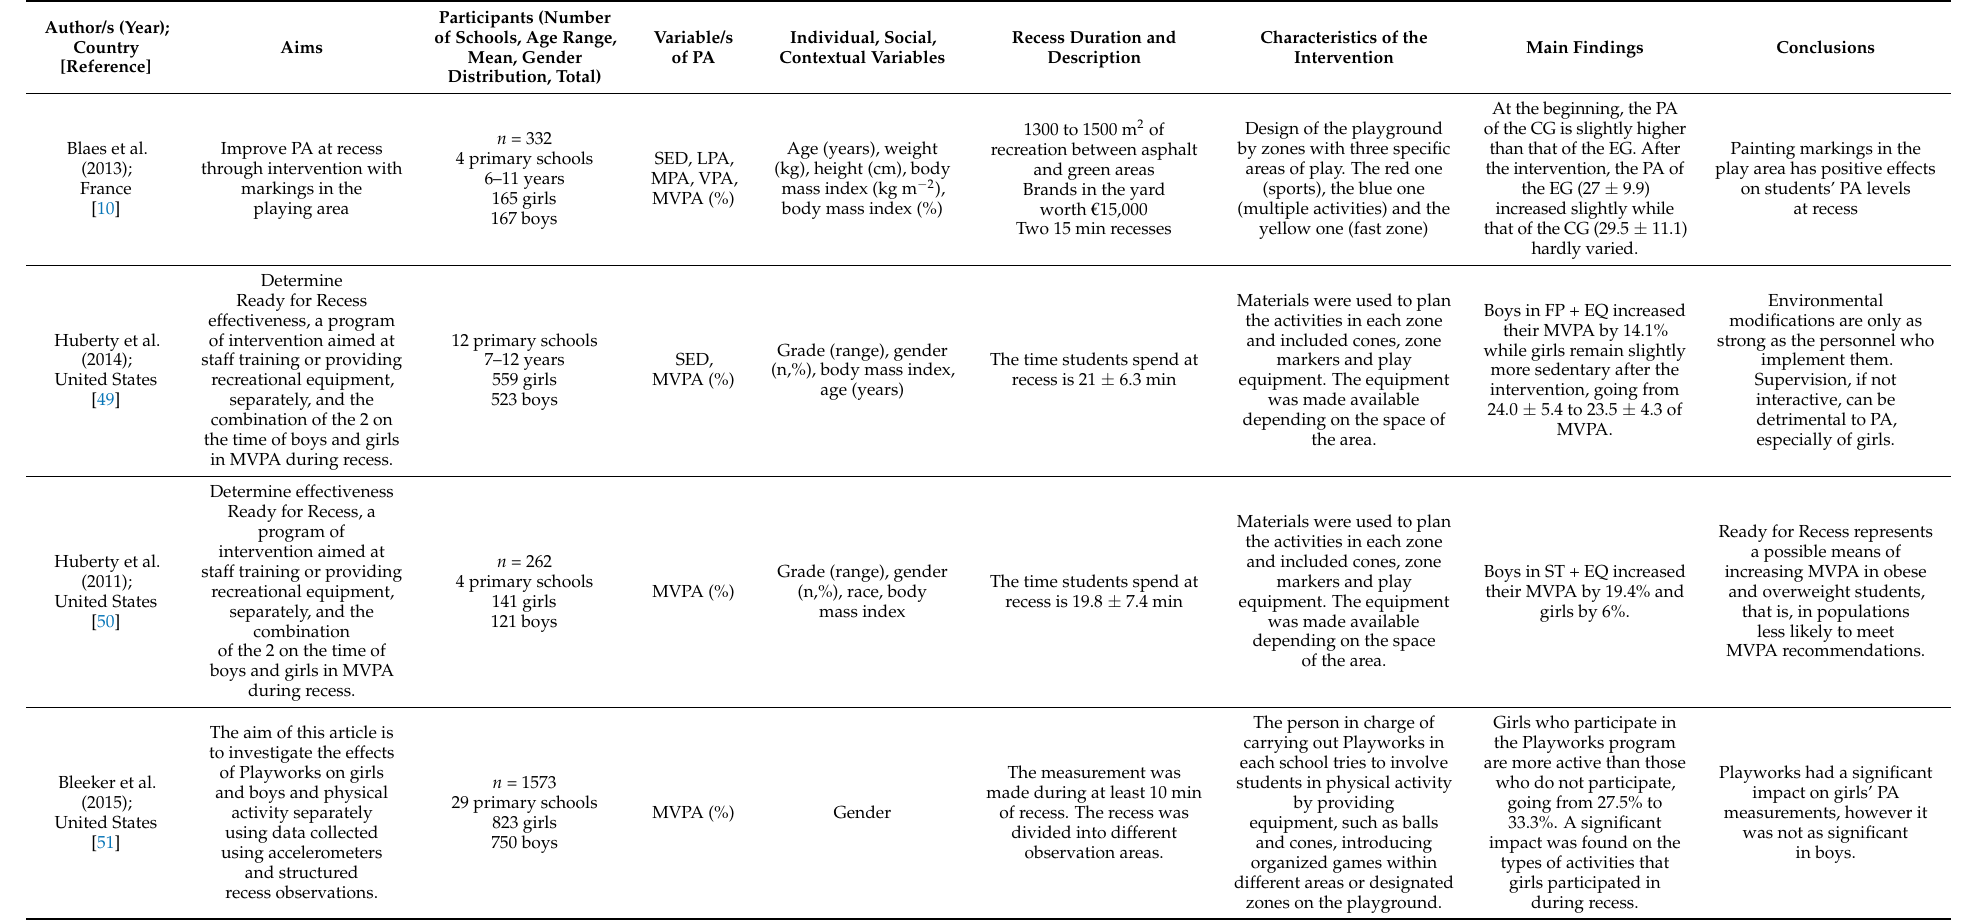
Table 5. Main characteristics of quasi-experimental